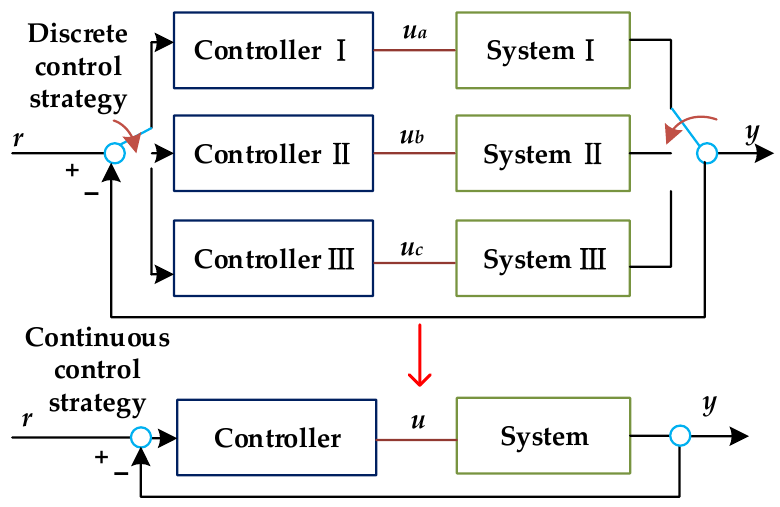
Figure 5. Motivation for a continuous control strategy.